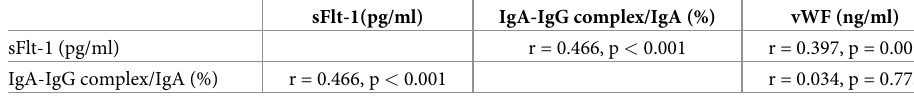
Table 1. The correlations between sFlt-1 and IgA-IgG complex, as well as